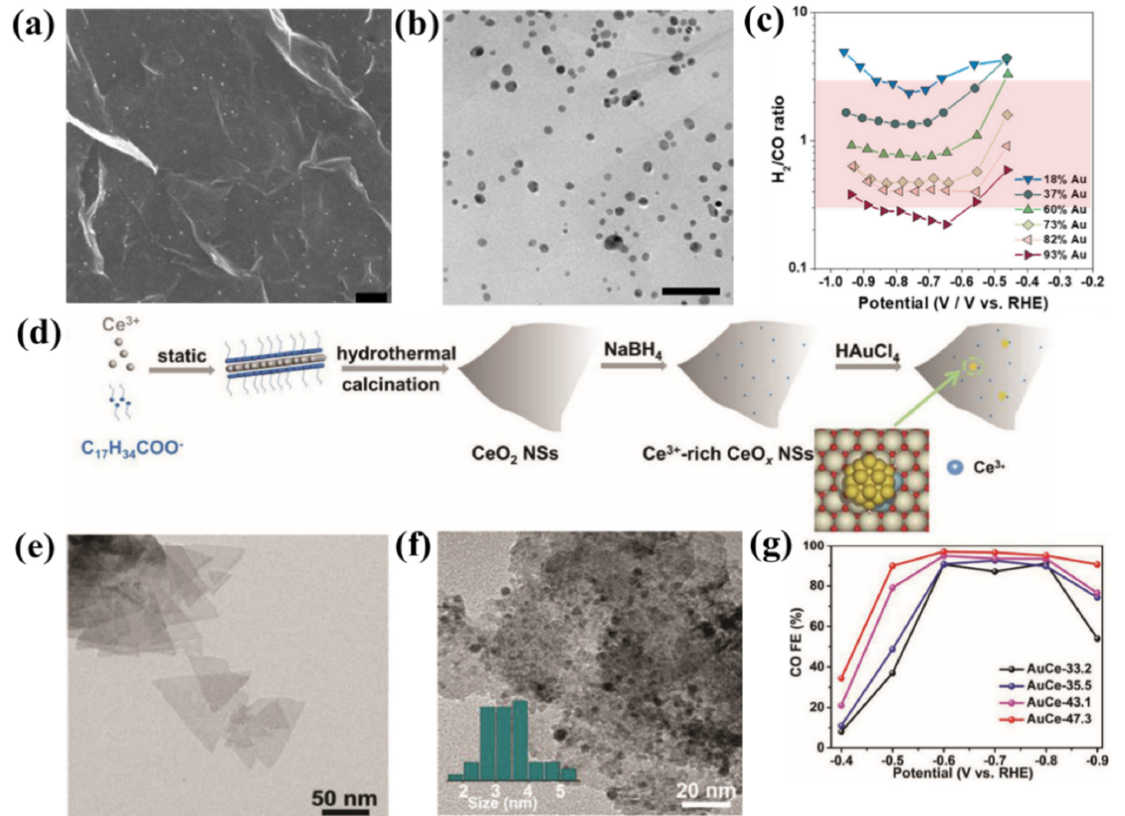
Figure 8. ( a ) Representative SEM images of prepared Au/TiNS electrodes with 60 wt% Au. ( b ) TEM image for the sample Au/TiNS-60% Au. ( c ) The range of H 2 to CO ratio for various applications. Reproduced with permission from Ref. [109]. Copyright 2018, American Chemical Society. ( d ) Schematic of the NaBH 4 pretreatment for the creation of Ce 3+ in CeO x NSs; the blue atom in the inset picture indicates the formed Ce 3+ . ( e ) TEM image of CeO 2 NSs. ( f ) TEM images of AuCe-47.3 and gold NPs size distribution. ( g ) CO FE at various potentials for Au-CeO x with different Ce 3+ concentrations. Reprinted with permission from Ref. [110]. Copyright 2019, Wiley-VCH.